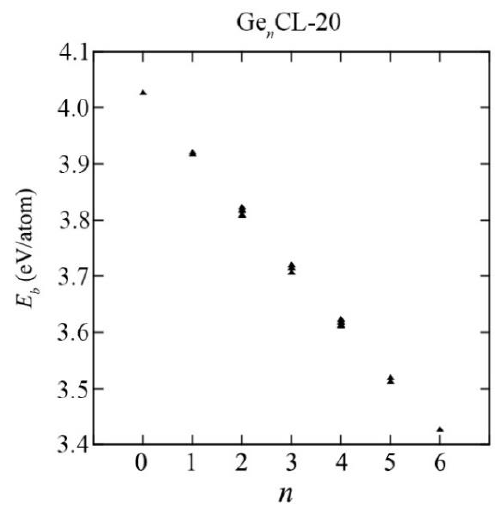
Figure 4. The binding energy versus the number of Ge-atoms n in the Ge n CL-20 molecule for all possible configurations obtained at the DFT/B3LYP/6-311(d,p) level of theory.